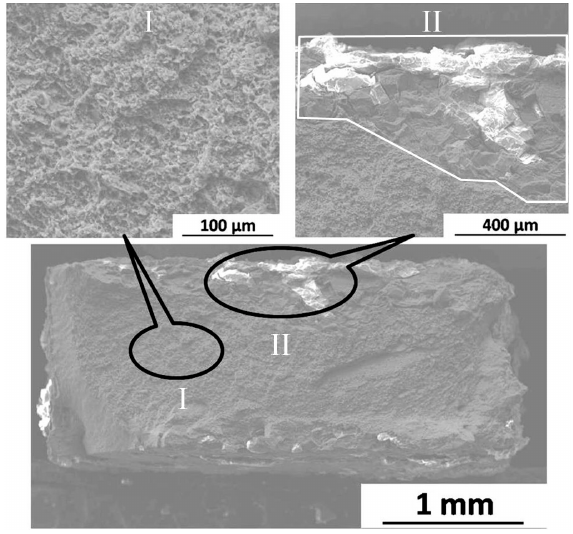
Figure 12. Fracture surface of FSP specimen after immersion for three days.